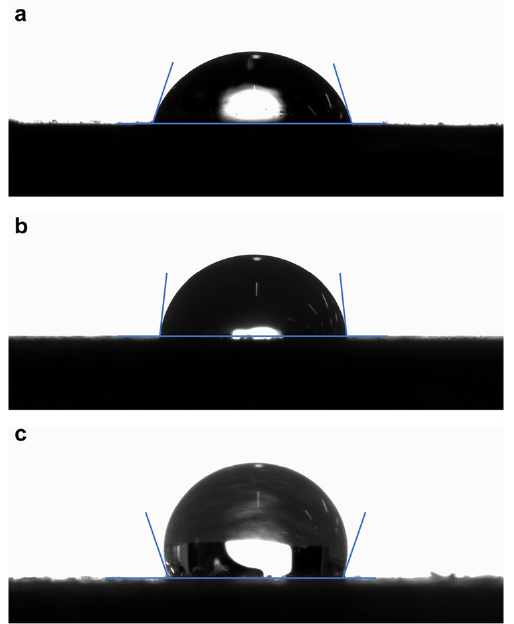
Figure 9. Optical images of water droplet on ( a ) TI-N, ( b ) TI-H and ( c ) TI-R.